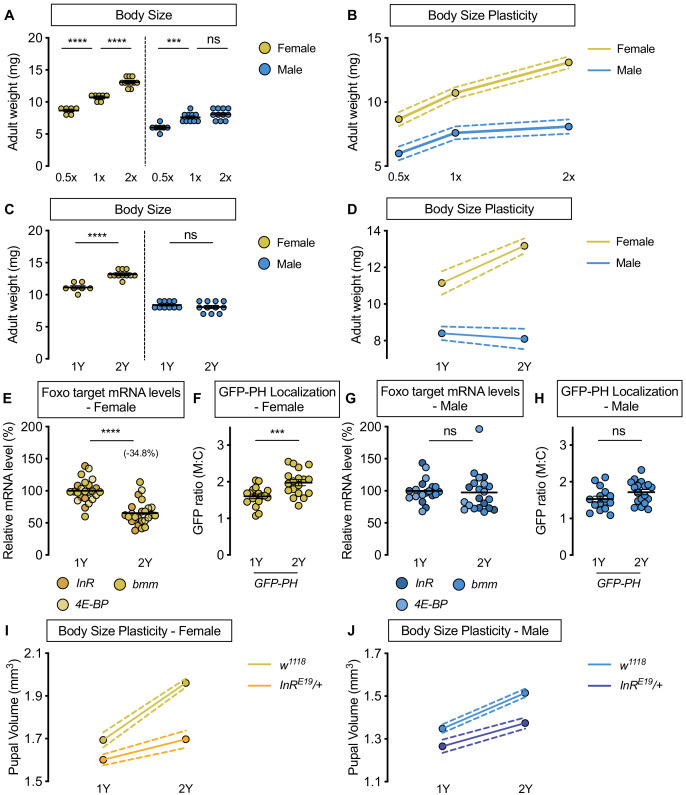
Upregulation of IIS activity is required for increased nutrient-dependent body size plasticity in females in a protein-rich diet.(A) Adult weight was significantly higher in w1118 males and females cultured on 1X compared with flies raised on 0.5X (p<0.0001 for both sexes; two-way ANOVA followed by Tukey HSD test). The magnitude of this increase in adult weight was the same in both sexes (sex:diet interaction p=0.3197; two-way ANOVA followed by Tukey HSD test). Adult weight was significantly higher in w1118 females raised on 2X compared to flies cultured on 1X; however, male adult weight was not significantly increased (p<0.0001 and p=0.4015, respectively; two-way ANOVA followed by Tukey HSD test), where the diet-dependent increase in adult weight was higher in females (sex:diet interaction p=0.0003; two-way ANOVA followed by Tukey HSD test). (B) Reaction norms for adult weight in response to changes in nutrient quantity in w1118 females and males, plotted using the data presented in panel A. n = 6–11 groups of 10 flies. (C) Adult weight was significantly higher in females cultured on 2Y compared with flies raised on 1Y; however, male adult weight was not significantly higher in flies raised on 2Y compared with males cultured on 1Y (p<0.0001 and p=0.7199, respectively; two-way ANOVA followed by Tukey HSD test, sex:diet interaction p<0.0001). (D) Reaction norms for adult weight in w1118 females and males reared on either 1Y or 2Y, plotted using data from panel C. n = 7–11 groups of 10 flies. (E) In females, mRNA levels of Foxo targets (insulin receptor (InR), brummer (bmm), and eukaryotic initiation factor 4E-binding protein (4E-BP)), were significantly lower in larvae raised on a protein-rich diet (2Y) compared with larvae raised on a diet containing half the protein content (1Y) (p<0.0001; Student’s t test). n = 8 biological replicates. (F) Quantification of the ratio between cell surface membrane-associated green fluorescent protein (GFP) and cytoplasmic GFP (GFP ratio [M:C]) in a dissected fat body of female larvae from the GFP-PH strain. The ratio was significantly higher in female larvae cultured on 2Y compared with larvae raised on 1Y (p=0.001; Student’s t test). n = 18 biological replicates. (G) In males, there was no significant difference in mRNA levels of Foxo targets between larvae raised on 2Y compared with larvae cultured on 1Y (p=0.7323; Student’s t test). n = 6–7 biological replicates. (H) In males, the M:C ratio for GFP-PH was not significantly different between males cultured on 2Y compared with larvae raised on 1Y (p=0.0892; Student’s t test). n = 15–18 biological replicates. (I) Pupal volume was significantly higher in both w1118 females and InRE19/+ females reared on 2Y compared with genotype-matched females cultured on 1Y (p<0.0001 for both genotypes; two-way ANOVA followed by Tukey HSD test); however, the magnitude of the nutrient-dependent increase in pupal volume was lower in InRE19/+ females (genotype:diet interaction p<0.0001; two-way ANOVA followed by Tukey HSD test). n = 58–77 pupae. (J) Pupal volume was significantly higher in both w1118 males and InRE19/+ males reared on 2Y compared with genotype-matched males cultured on 1Y (p<0.0001 for both genotypes; two-way ANOVA followed by Tukey HSD test). While we observed a sex:diet interaction in the w1118 control genotype, there was no sex:diet interaction in the InRE19/+ genotype (p<0.0001 and p=0.7104, respectively; two-way ANOVA followed by Tukey HSD test). n = 47–76 pupae. For body size plasticity graphs, filled circles indicate mean body size, and dashed lines indicate 95% confidence interval. *** indicates p<0.001, **** indicates p<0.0001; ns indicates not significant; error bars indicate SEM.